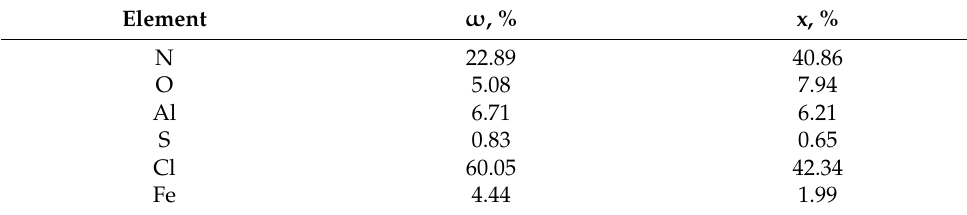
Figure 2. Perforation morphology of the heat exchanger tube bundle. Table 1. Composition of scaling